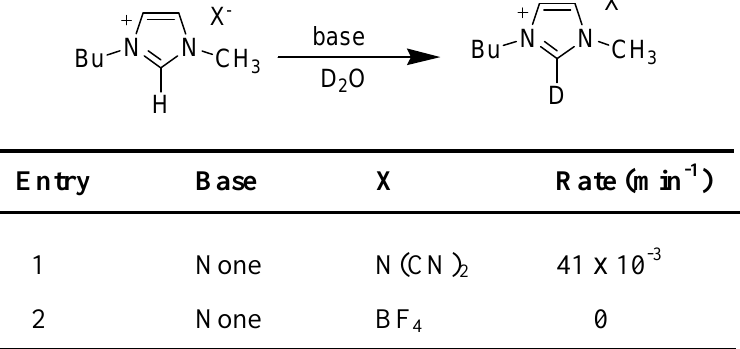
Table 3. Effect of anion on the H-D exchange rate of C2 hydrogen of [bmim] cation. N N